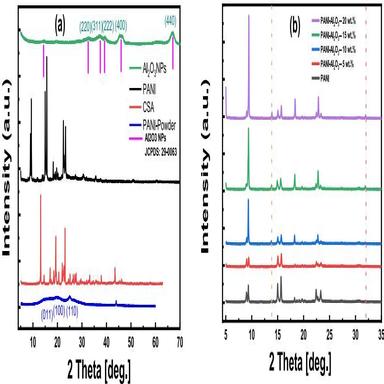
(a) X-ray Diffraction Analysis of PANI powder, CSA, PANI film and Al2O3 NPs and (b) X-ray Diffraction Analysis of PANI and PANI-Al2O3 nanocomposite films.